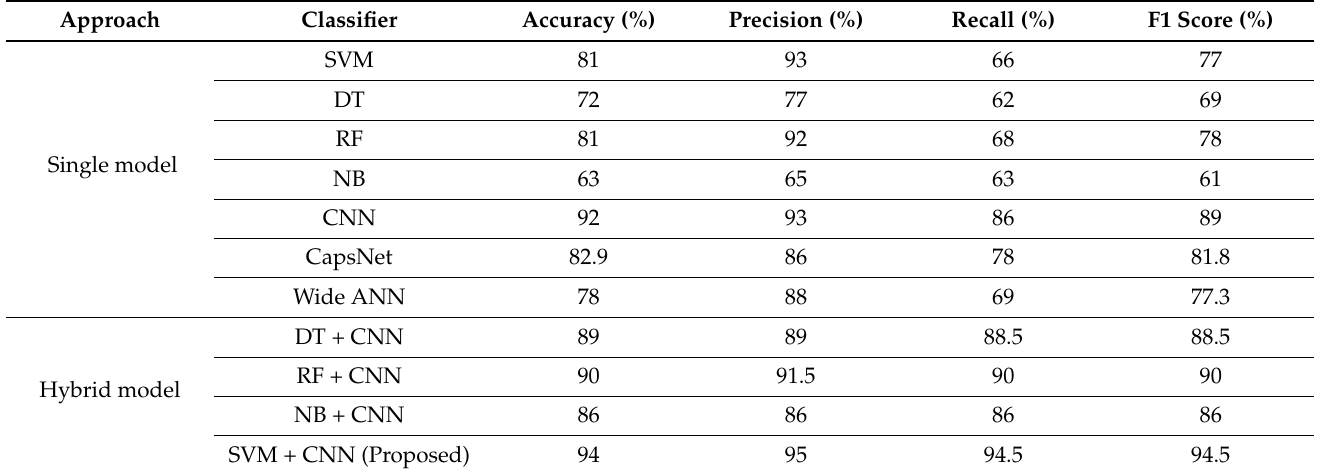
Table 1. Performance comparison of hybrid models.